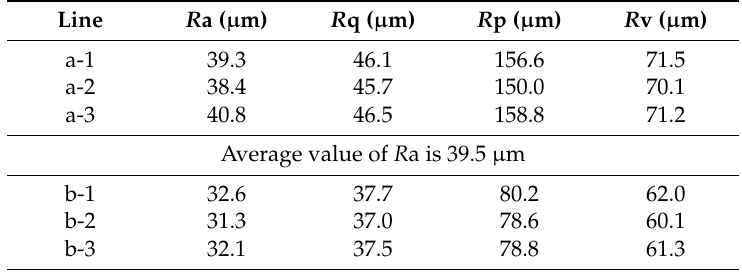
Figure 7. Typical surface roughness profile curve of S1 ( A )the direction of the measuring line; ( B ) the surface roughness value of different measuring line. surface roughness value of different measuring line. Table 2. The surface roughness parameters of different measurement methods. Table 2. The surface roughness parameters of different measurement